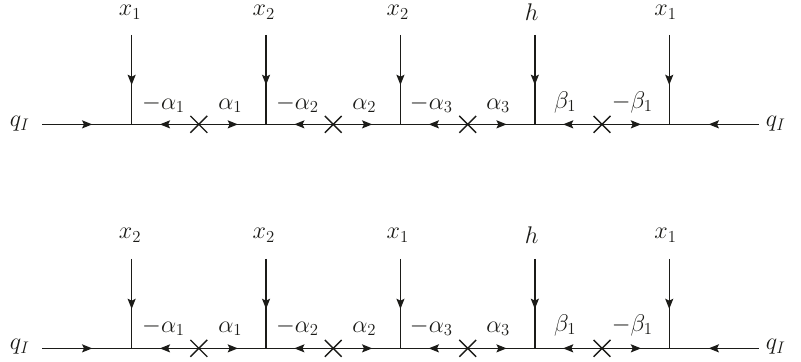
Figure 12 . Example of two diagrams in the case of I = J providing the same Yukawa couplings, but where only one of them can be protected. They contain two di(cid:11)erent 45 or 210 (cid:12)elds with charges x 1 and x 2 . For any choice of global charges in the (cid:12)rst diagram, the symmetric diagram with a pair of legs x 1 - x 2 on both sides of H can also be constructed. In contrast, the second diagram, where the (cid:12)elds on the left-hand side of the Higgs (cid:12)elds are permuted, can be protected by a suitable choice of charges, for example q I = 0, x 1 = 3 and x 2 = 1. reordering of f (cid:11) ; (cid:12) g and some reordering of f (cid:11) 0 ; (cid:12) 0 g while retaining the same i j k l MSSM Yukawa